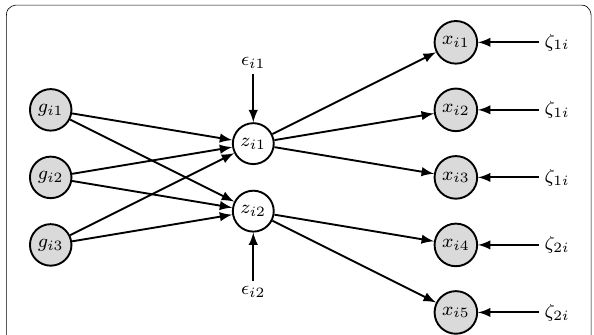
Fig. 1 The graphical structural equation model. Observed variables are shown in grey circles, latent variables in white circles, and error variables without circles. This example contains two latent variables, both with their own set of observed brain region measurements. This structure, where the latent variables define groups of region measurements, is defined by prior knowledge on these brain regions. We use spatially resolved gene expression data of the healthy human brain to define these region